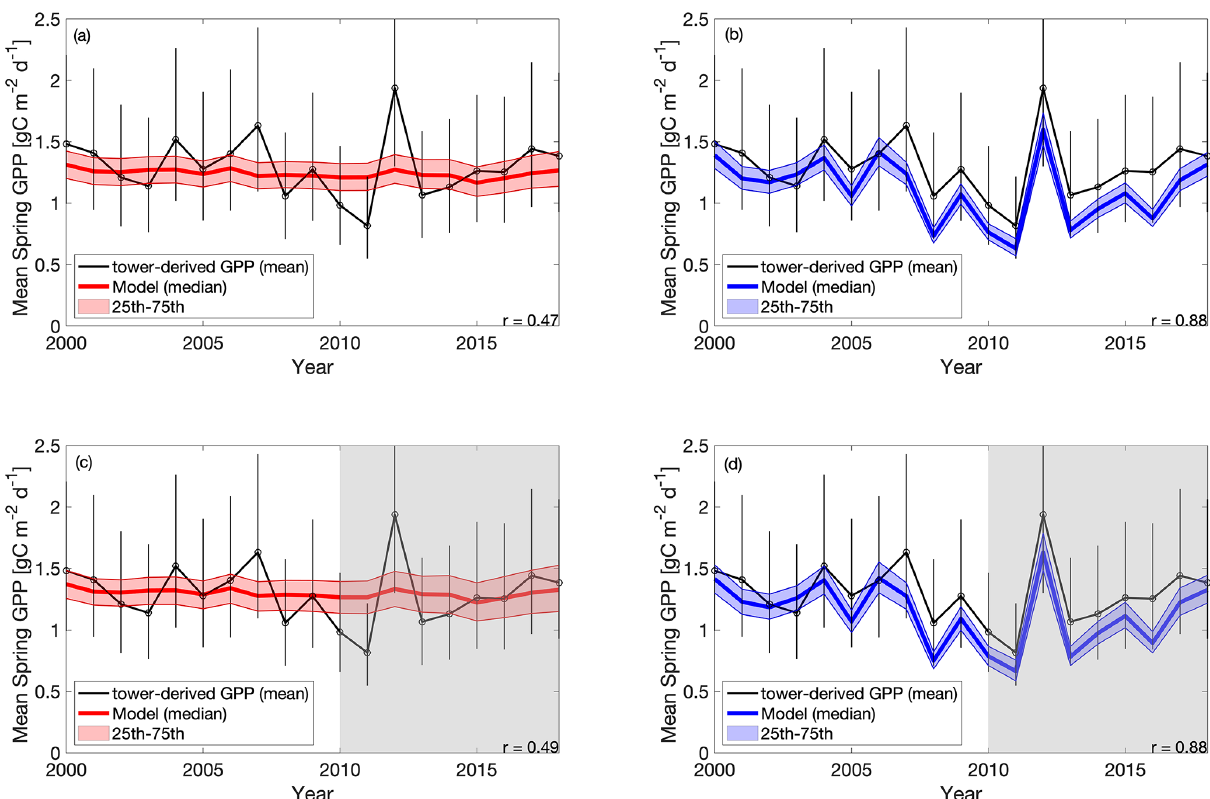
Figure 5. Tower-derived (black line) mean spring (March–May) GPP with model interquartile range (shaded area) and median (bold colored line) spring GPP outputs for (a) CARD, (b) CARDcold, (c) CARD-Half and (d) CARDcold-Half experiments. The grey regions indicate no data assimilation (i.e., testing window). Model experiments are the same as in Fig. 4. Uncertainty is exp ( number of months on average ( n =